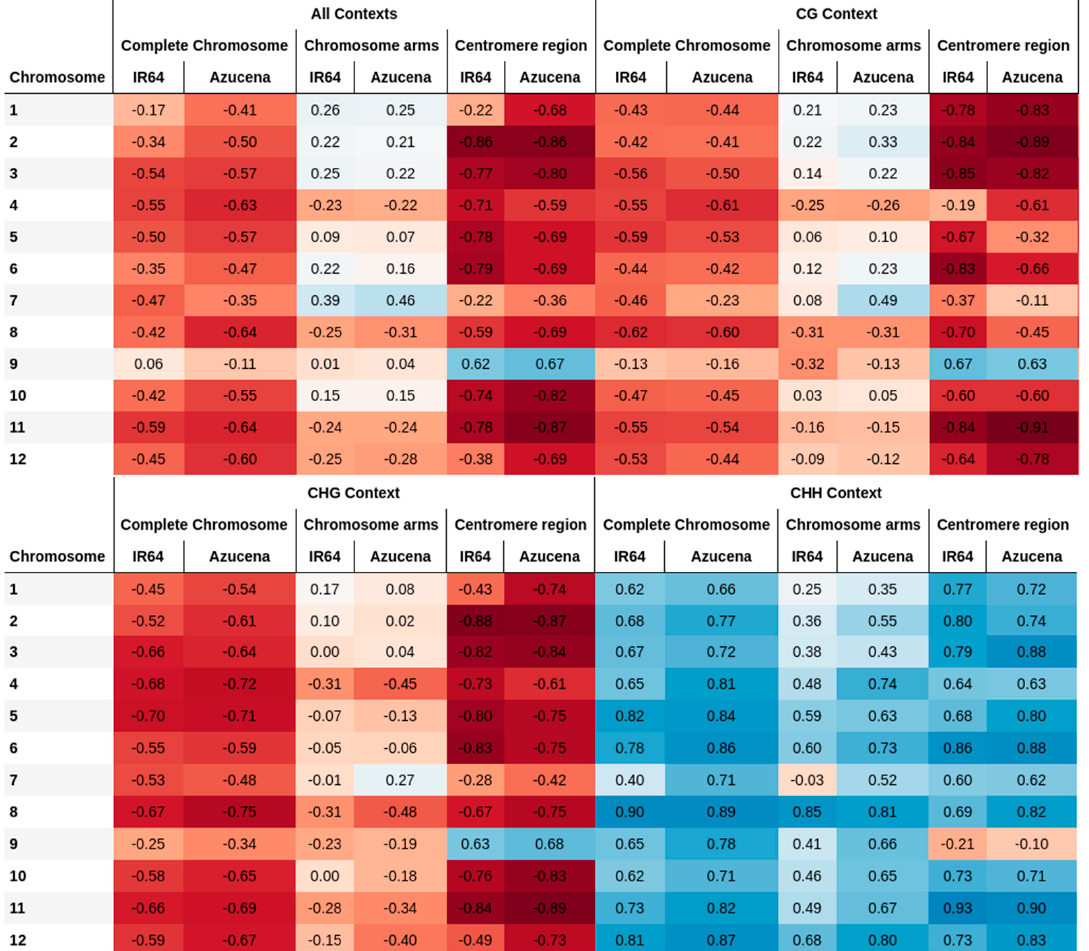
Figure 7. Shap values and contributions of features CG, CHG, and CHH to the prediction of recom- bination rates, using IR64 and Azucena data: ( a ) Shap summary plot of features for the IR64 variety; ( b ) Shap summary plot of features for the Azucena variety; ( c ) Shap values for the IR64 variety; and ( d ) Shap values for the Azucena variety.